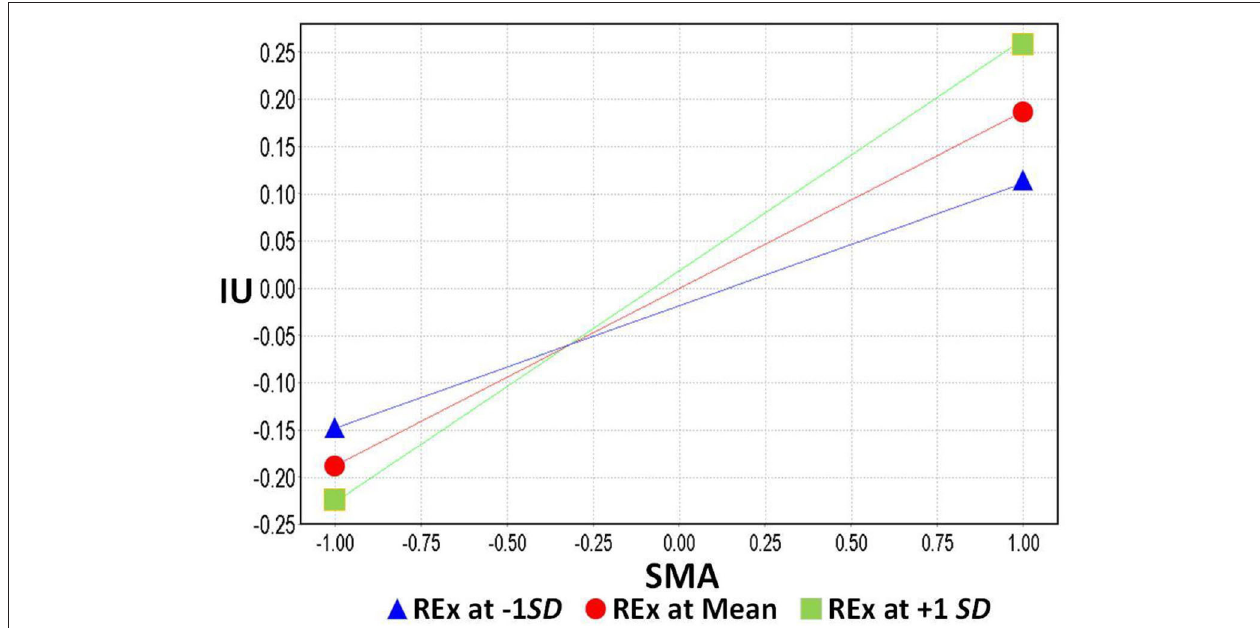
FIGURE 3 | Moderating effect of regular exercise on social media addiction and internet use.